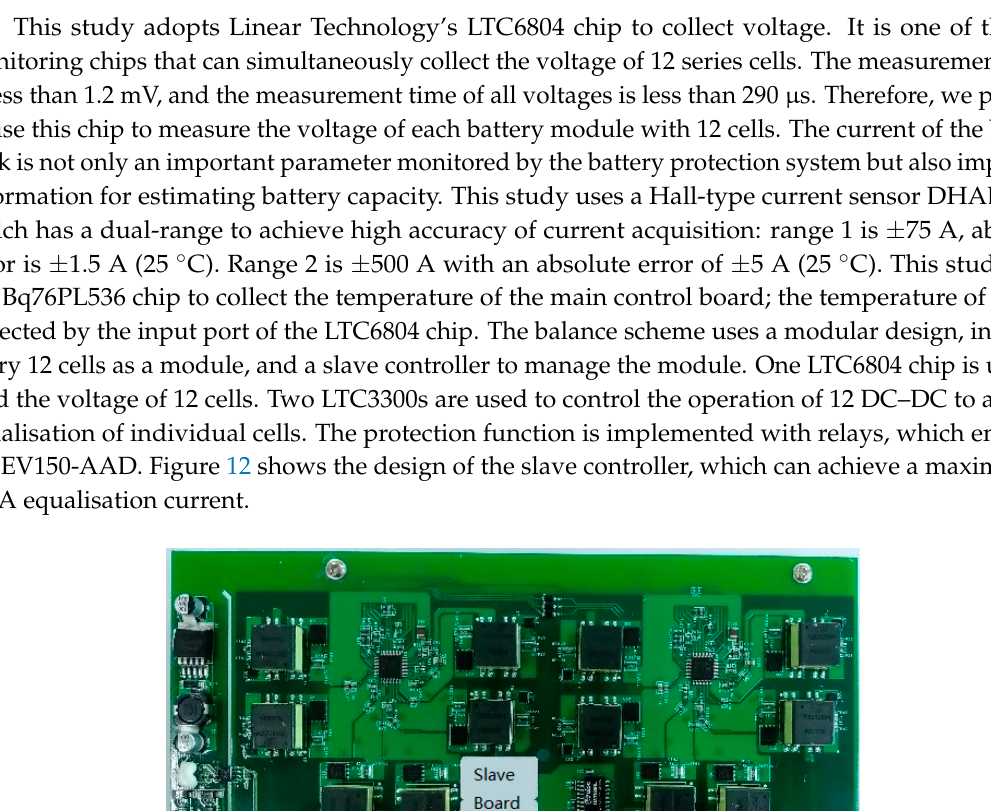
Figure 11. Block diagram of main control unit.